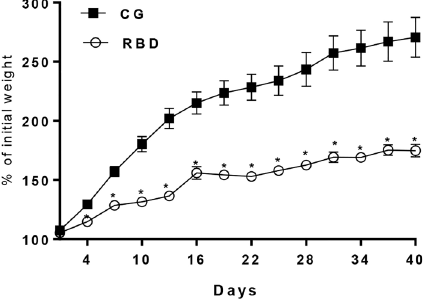
Figure 1. Weight gain (% of initial weight) every 3 days of C57BL6J nourished (control group, CG) and regional basic diet (RBD) undernourished mice during 40 days of dietary intervention. Data are reported as means ± SE. *P o 0.05, two-way ANOVA. Table 4. Histopathological liver scores in C57BL6J nourished and undernourished mice following 40 days of dietary intervention.